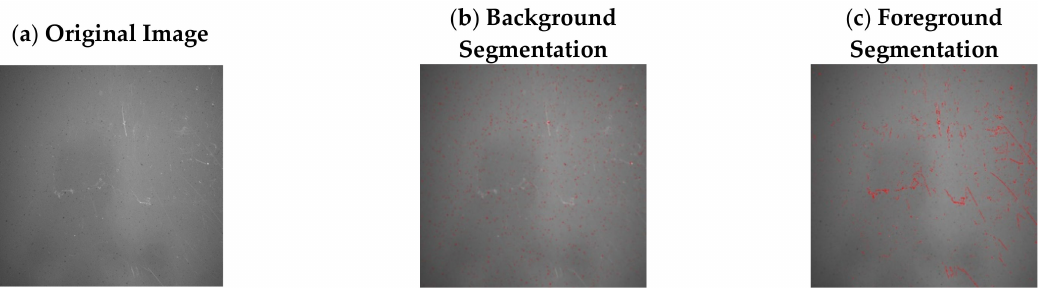
Figure 8. Computer Vision-based Defects Detection on Red Color Product.